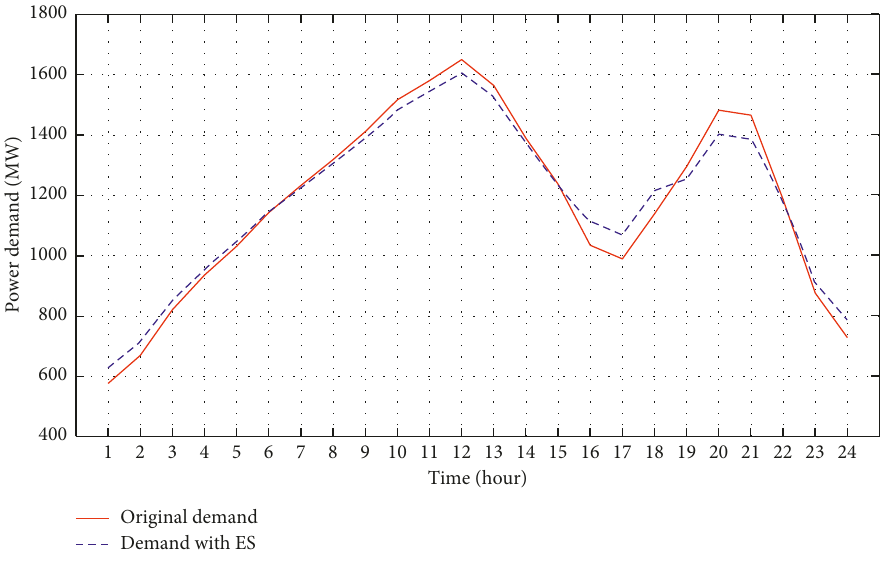
Figure 6: Effect of ES on load